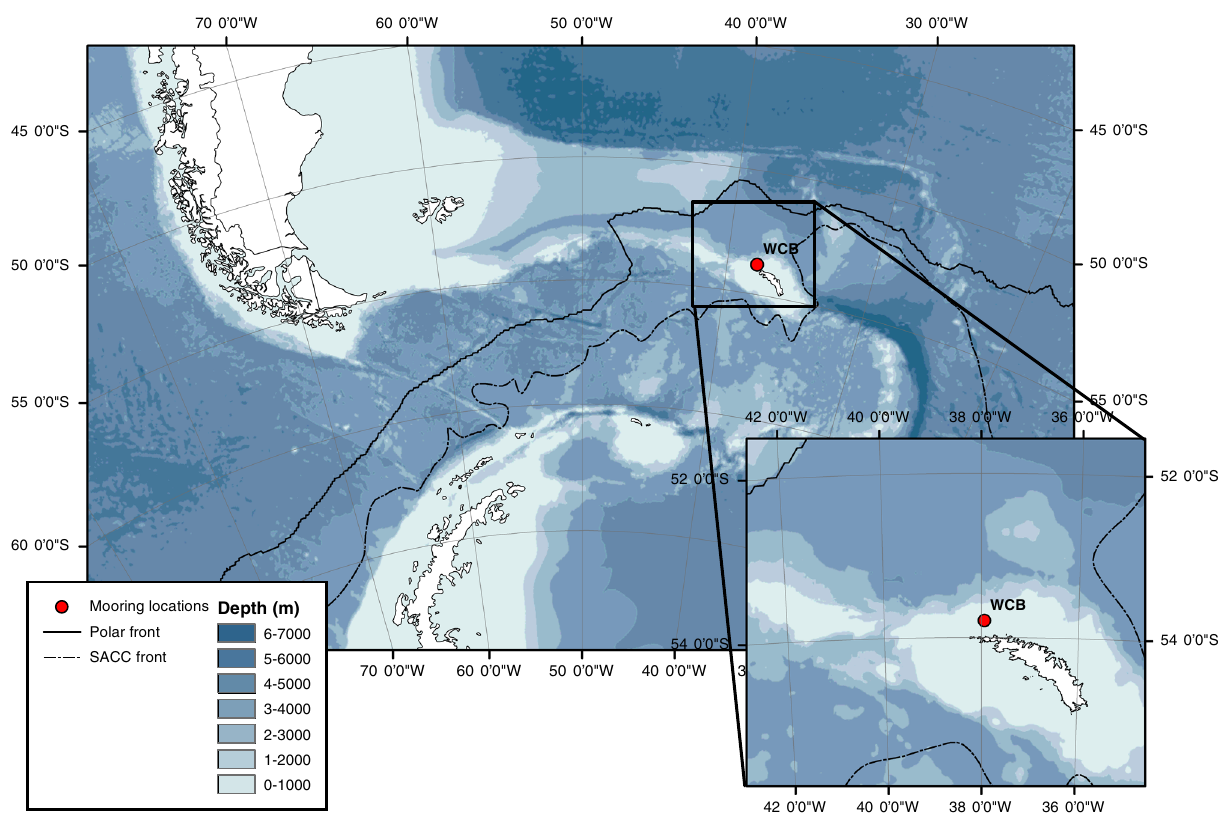
Fig. 5 Location map Location of sediment trap mooring (WCB) in the Scotia Sea, Southern Ocean. Bathymetry data from Gebco. Map generated using arcmap